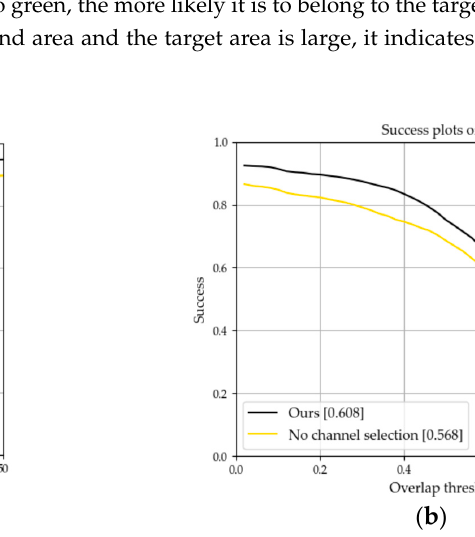
Figure 6. Comparison of with and without channel selection strategy. ( a ) Precision plots of trackers with/without channel selection strategy; ( b ) Success plots of trackers with/without channel selection strategy. Table 3. Tracking performance comparison with and no channel